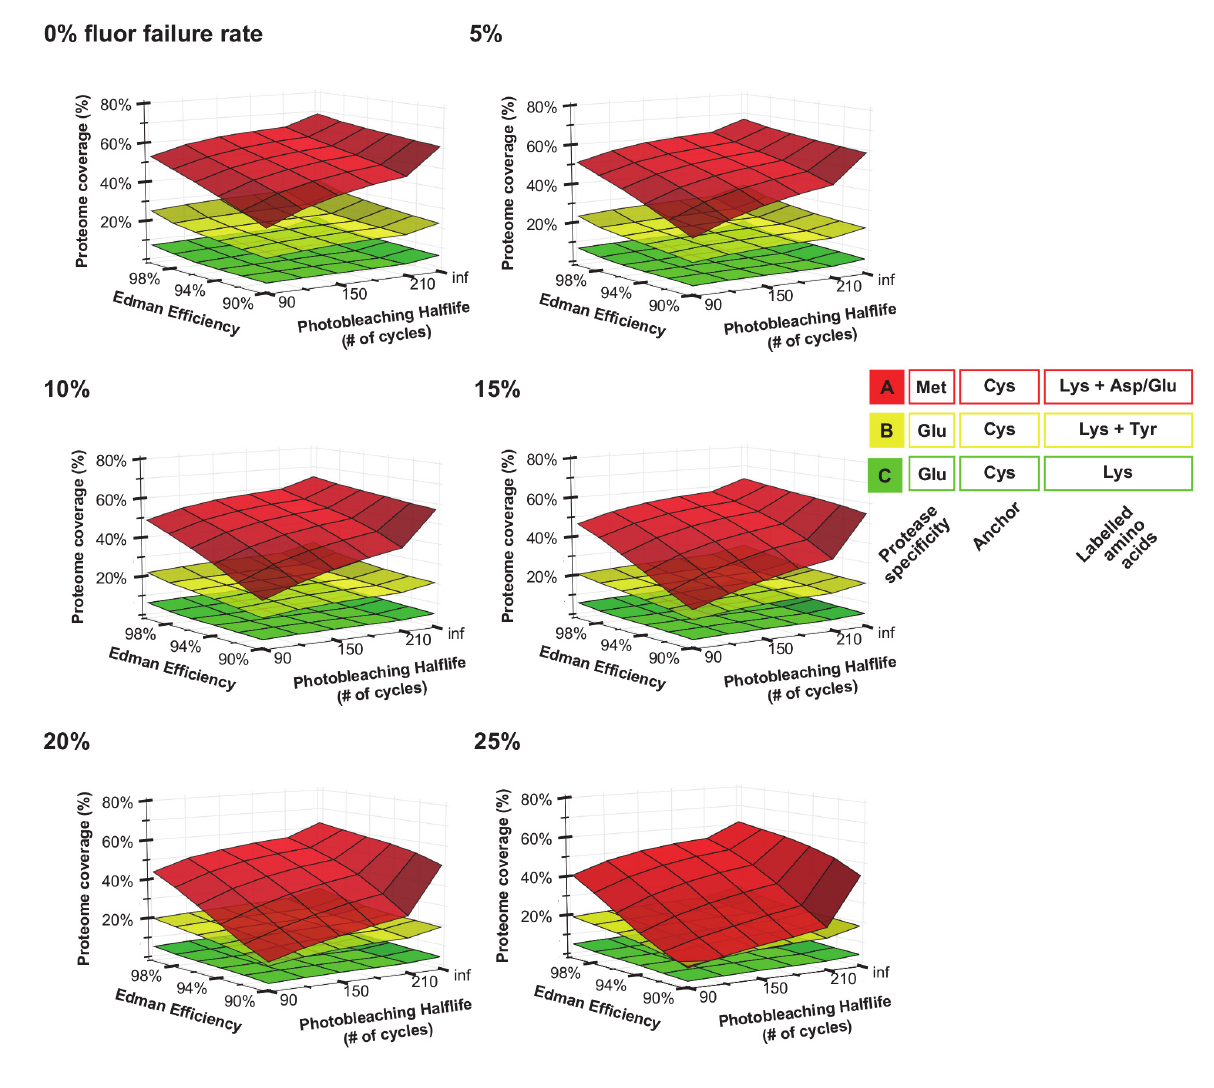
Fig 7. Surface plots illustrate the consequences of differing rates of Edman efficiency, photobleaching, and fluorophore failure rates. Each panel summarizes the consequences of varying rates of photobleaching and Edman failures for a different fixed fluorophore failure rate, ranging from 0% to 25%, as calculated after simulating 30 experimental cycles on the complete human proteome at a simulation depth of 10,000 copies per protein. Photobleaching shows the strongest negative impact on proteome coverage when compared to other errors; increasing the number of distinguishable labels strongly increases proteome coverage. Labeling and immobilization schemes are denoted as in Fig. 2. For comparison, literature evidence suggests that common failure rates of fluorophores may be about 15 – 20% [18,32], Edman degradation proceeds with about 94% efficiency [33], and the mean photobleaching lifetime of a typical Atto680 dye is about 30 minutes [23], corresponding to 1800 Edman cycles, assuming 1 sec exposure per Edman cycle. Thus, we expect error rates to be sufficiently low for effective